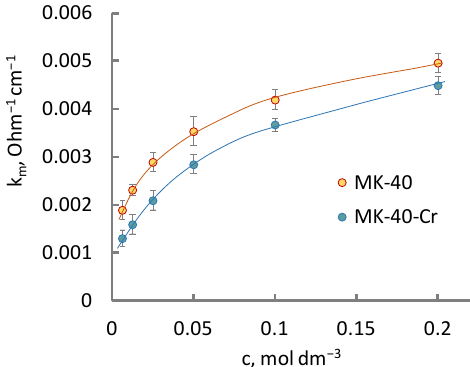
Figure 6. Concentration dependence of the electrical conductivity of MK-40 in Na 2 SO 4 solutions.